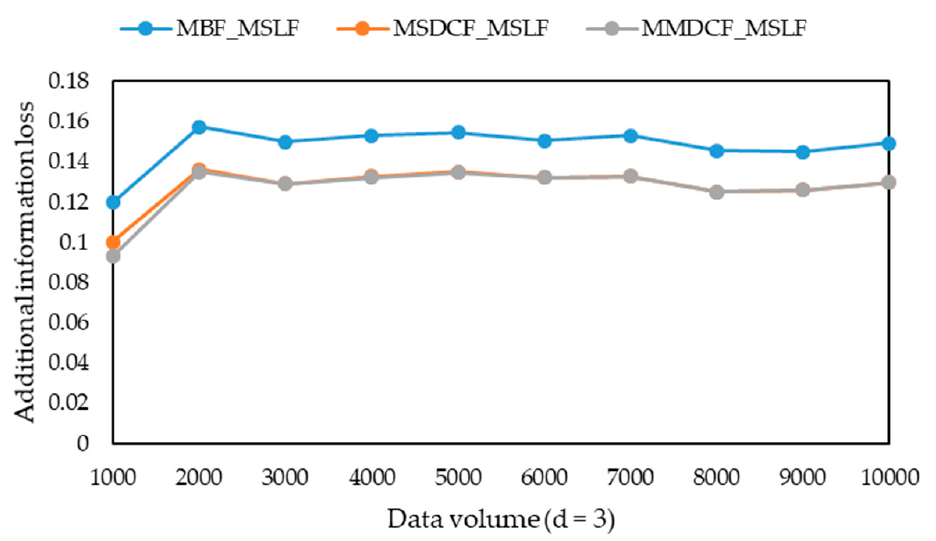
Figure 20. The additional information loss of MBF-MSLF, MSDCF-MSLF and MMDCF-MSLF with di ff erent data volumes ( d = 3).